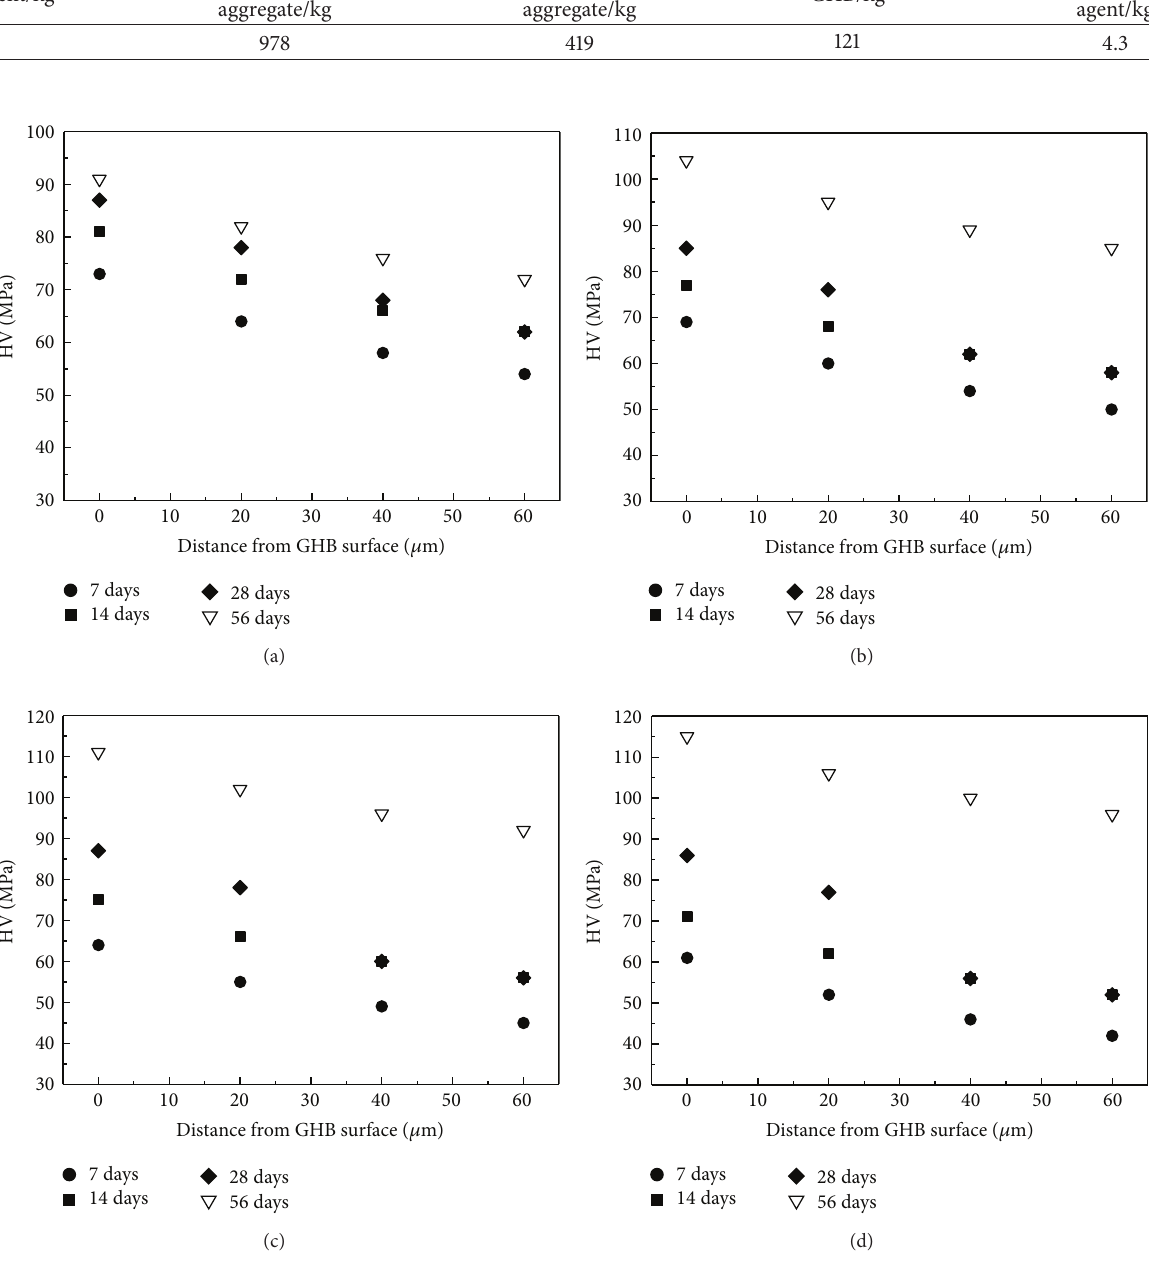
Figure 9: The influence of prewetting time of GHB on the interfacial HV of lightweight aggregate concrete: (a) prewetting time 0s, (b) prewetting time 60 s, (c) prewetting time 90s, and (d) prewetting time